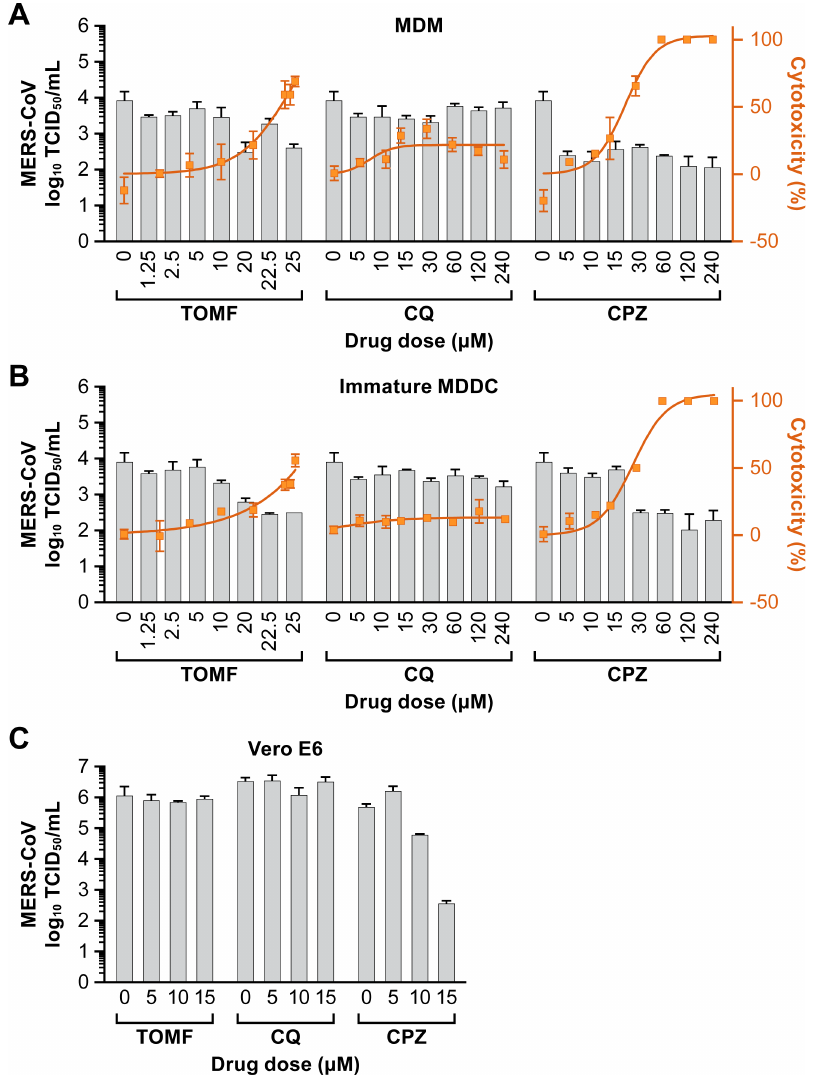
Fig 5. Antiviral activity of three compounds on MERS-CoV infection in MDMs and immature MDDCs. (A) Monocyte-derived macrophages (MDMs), (B) immature dendritic cells (MDDCs) and (C) Vero E6 cells were pretreated with toremifene (TOMF), chloroquine (CQ), and chlorpromazine (CPZ) for 1 h followed by inoculation with MERS-CoV Jordan variant at an MOI = 0.1. Supernatants collected at 72 h post infection (hpi) for APCs and 48 hpi for Vero E6 cells were inoculated onto Vero E6 cells pre-seeded overnight in 96 well plates and incubated for 6 days. Wells with cytopathic effects were counted, and TCID 50 was determined using the Reed-Muench method. Cytotoxicity was measured in parallel using luminescent cell viability assay at 48 h after compounds addition to the mock-infected MDMs and immature MDDCs. Antiviral activity is shown in gray and cytotoxicity is shown in orange. Results are representative of 2 individual experiments with 3 replicates in each (means ± standard error of the means